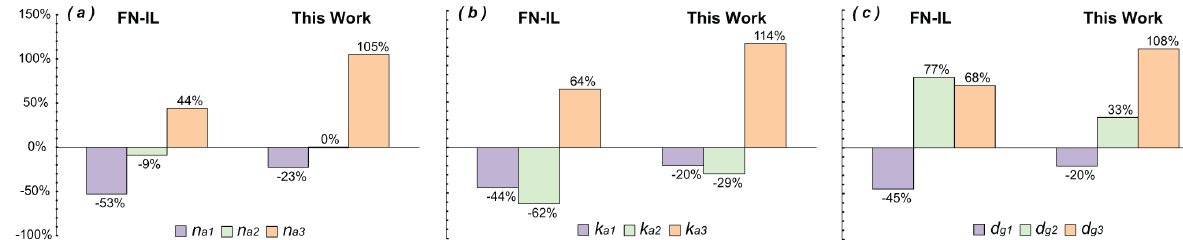
Figure 4. Mean relative percent error, (cid:15) , between sensitivities computed with the detailed parcel-model simulations and the parameteriza- tion results. Comparisons are shown here for (a) sensitivity to aerosol number ∂N d /∂n a ∂N d /∂κ a , (c) sensitivity to aerosol geometric mean diameter ∂N d /∂d g i of this work. Sub-indices follow the notation of Table